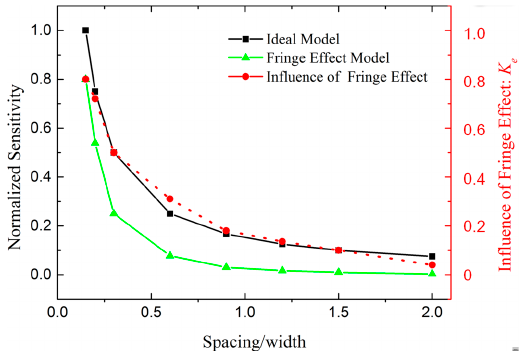
Figure 8. Calculation and Finite Element Modeling (FEM) results for the sensitivity of the transducer considering the fringe effect with different ratios of the capacitor spacing and electrode width ( d / a ).